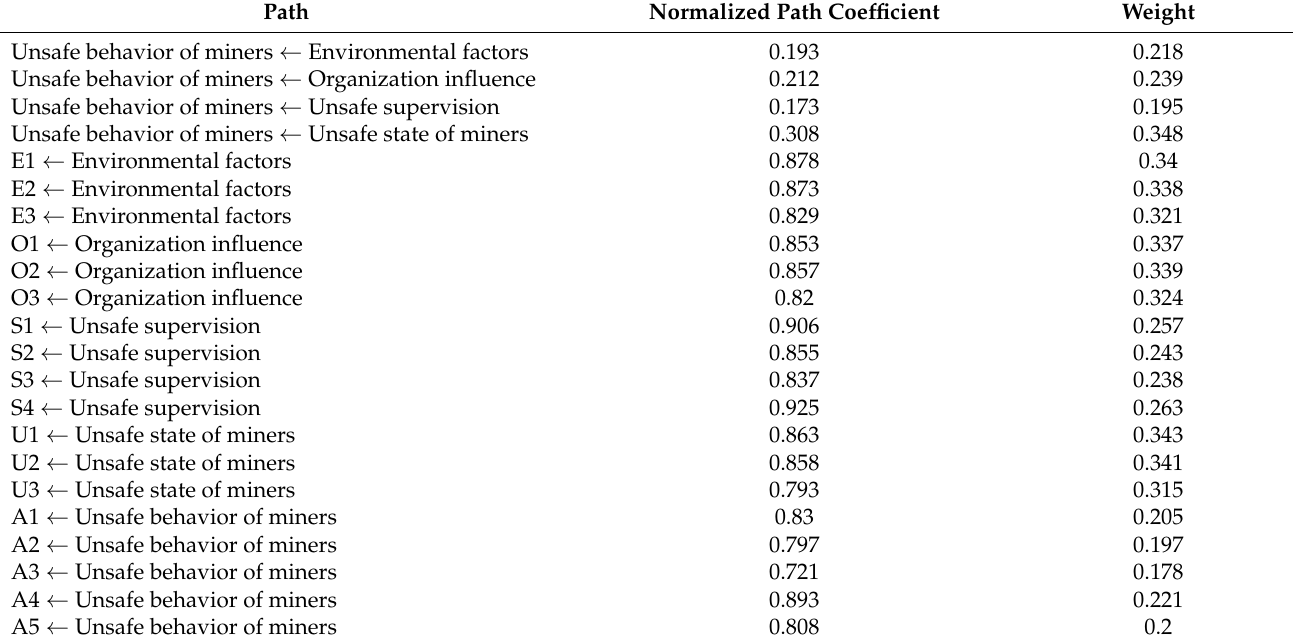
Table 8. Standardized path coefficients and corresponding